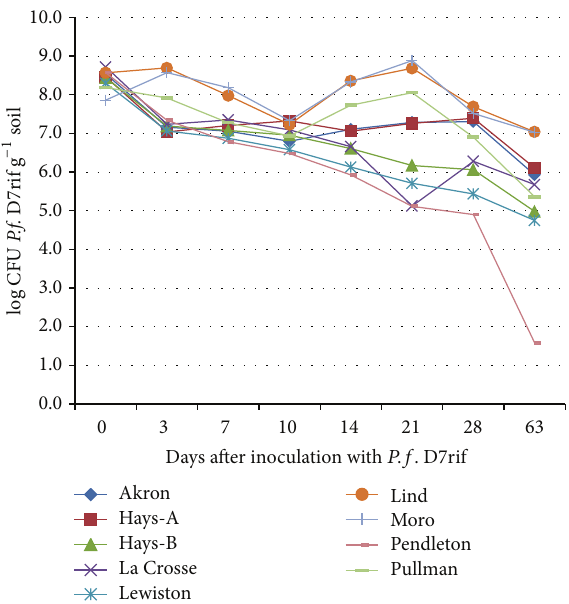
Figure 2: Recovery of P.f. D7rif in log CFU g −1 from nine different soilsovera63-dayincubationat5 ∘ C.Adifferencegreaterthanlog 1.0 indicates significant difference at 𝑃 ≤ 0.05 .